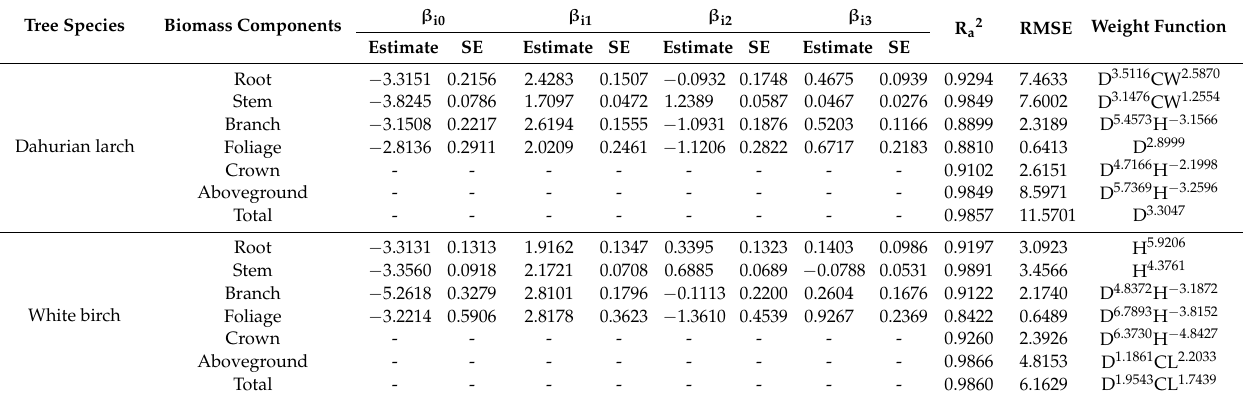
Table 7. Model coefficient estimates, standard errors, goodness-of-fit statistics, and weight functions for the additive system of biomass equations based on three predictors (D, H, and crown attributes, namely